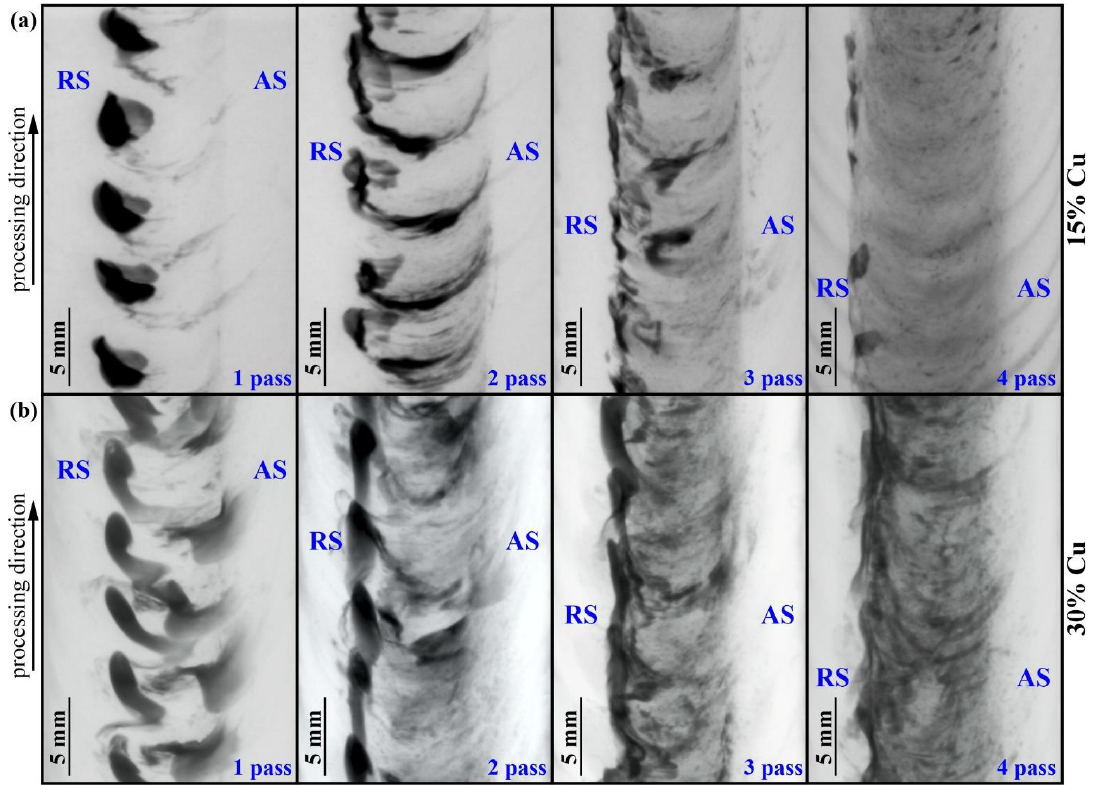
Figure 8. The X-ray computer tomography in-plane images of samples with 15 ( a ) and 30 vol.% ( b ) Cu obtained from samples with 1 to 4 passes after FSP.